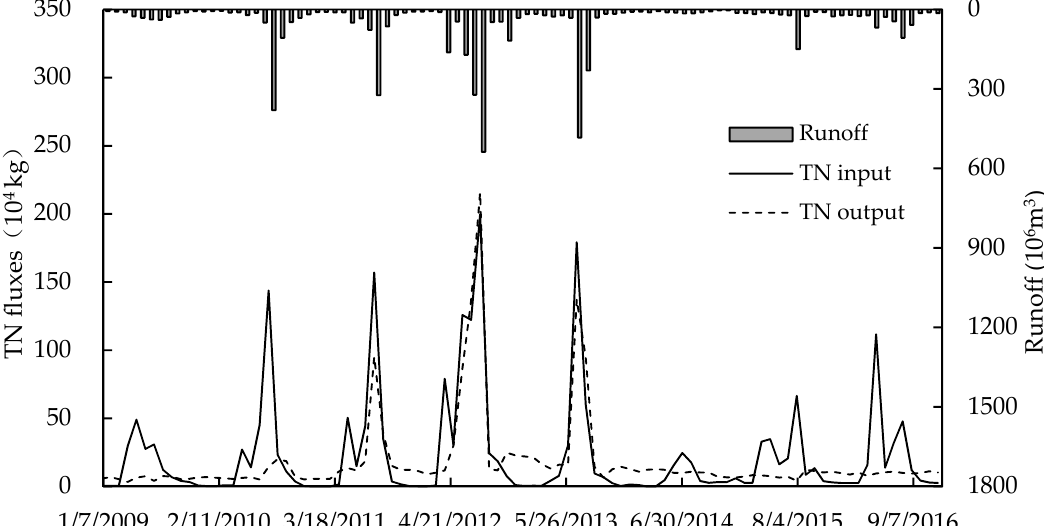
Figure 4. The runoff and TN fluxes of the Biliuhe reservoir.